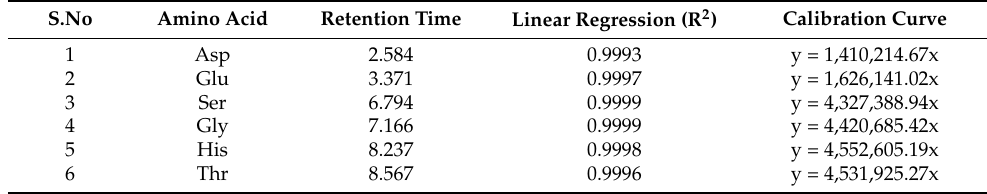
Table 1. Calibration data of 17 amino acids